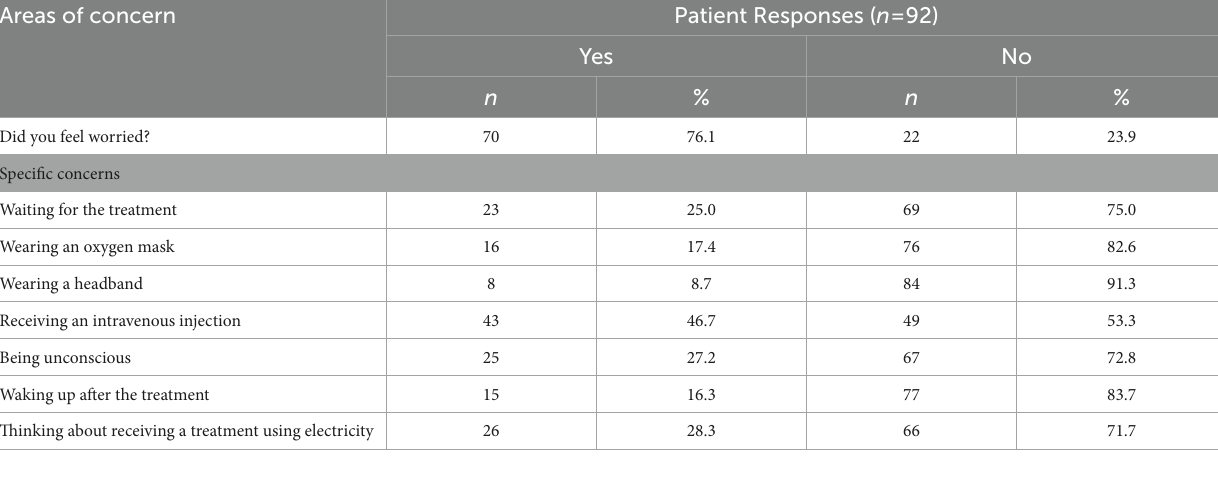
TABLE 5 Patient experiences of electroconvulsive therapy adverseeffects.